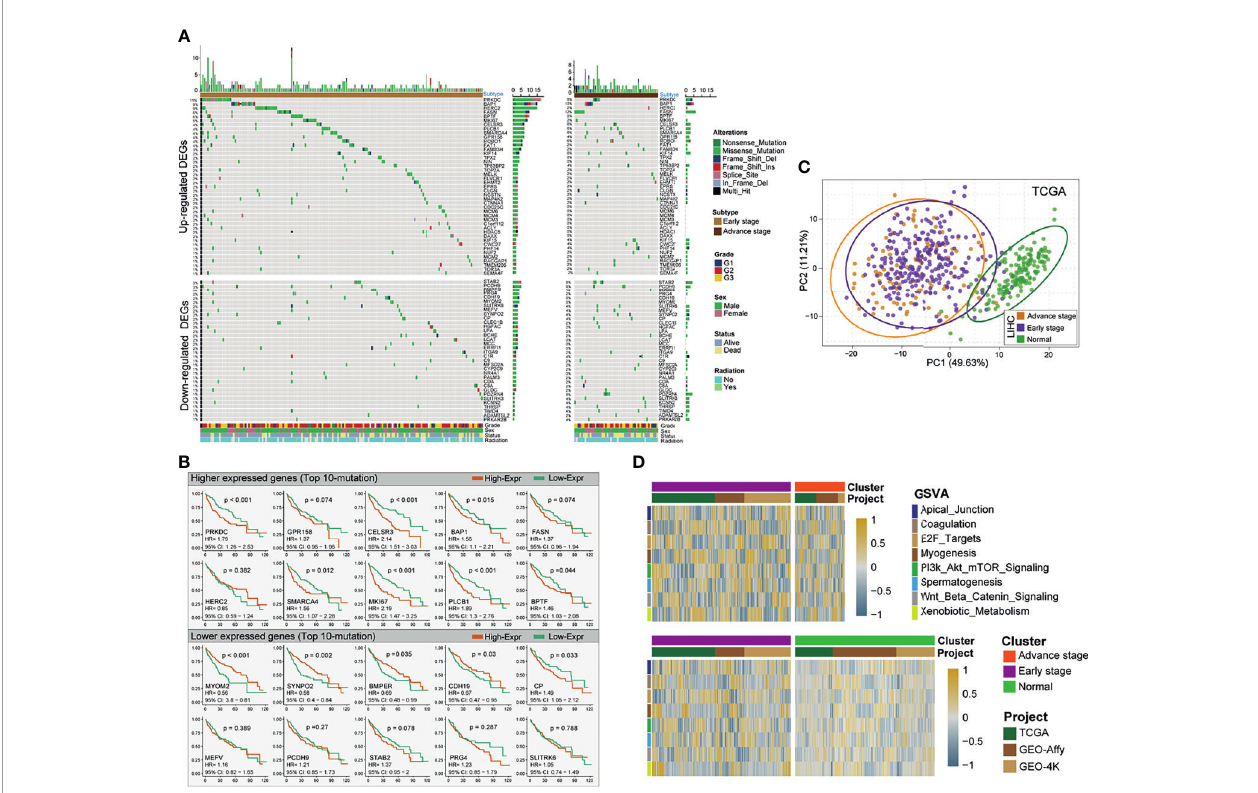
FIGURE 2 | Identi fi cation of differentially expressed HCC-related genes and prognostic signature. (A) Mutational landscape of signi fi cant upregulated/downregulated DEGs of HCC patients with two clinical pathological stages (left pro fi le, eHCC; right pro fi le, aHCC). The right panel is mutation frequency. The top panel shows mutation load of each patients. The middle panel depicts mutation types color coded differently. The bottom panel displays clinical features such as tumor grade, radiation, gender, and vital status. (B) Kaplan – Meier survival analyses of selective mutational DEGs. Top 10 mutational DEGs are shown in the graph, the top panel shows upregulated DEGs, and bottom panel show downregulated DEGs. Patients are strati fi ed into low (orange) and high (green) immune risk groups with a cutoff of the maximum value from survminer package. Patients are strati fi ed into low-risk (red) and high-risk (blue) groups with a cutoff of the maximum statistic value in TCGA. (C) Principal component analysis (PCA) for the transcriptome pro fi les of signi fi cant prognostic DEG patterns, including eHCC, aHCC, and non-tumor groups. (D) GSVA enrichment analysis showing the activation states of speci fi c DEG biological process in distinct subgroups of HCC. The heatmap was used to visualize these biological processes; and the brown color represents activated processes, and navy blue represents inhibited processes. The three independent cohorts were used as sample annotations. Top: eHCC vs. aHCC. Bottom: eHCC vs. non-tumor. HCC, hepatocellular carcinoma; DEG, differentially expressed gene; eHCC, early- stage hepatocellular carcinoma; aHCC, advanced-stage hepatocellular carcinoma; TCGA, The Cancer Genome Atlas; GSVA, gene-set variation